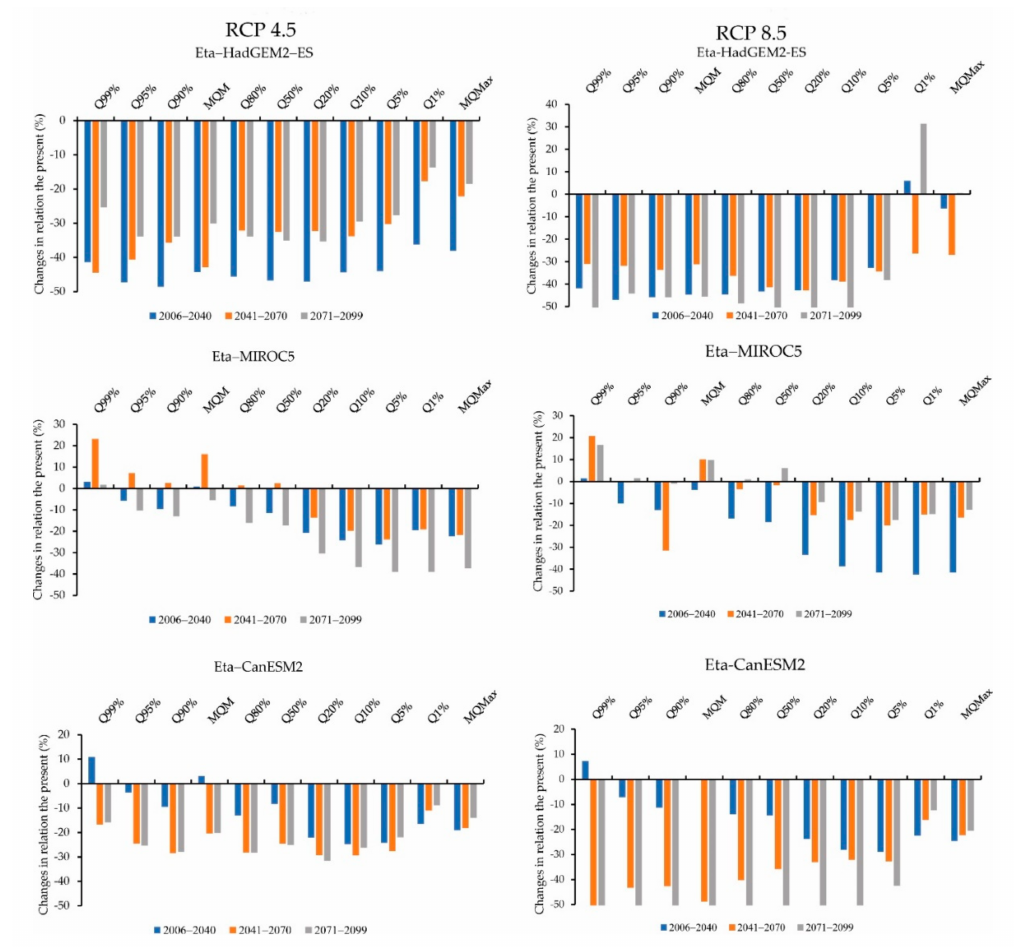
Figure 10. Changes (%) in the FDC indicators for the GRH-Furnas basin projected by the LASH model combined with the RCMs under RCP4.5 and